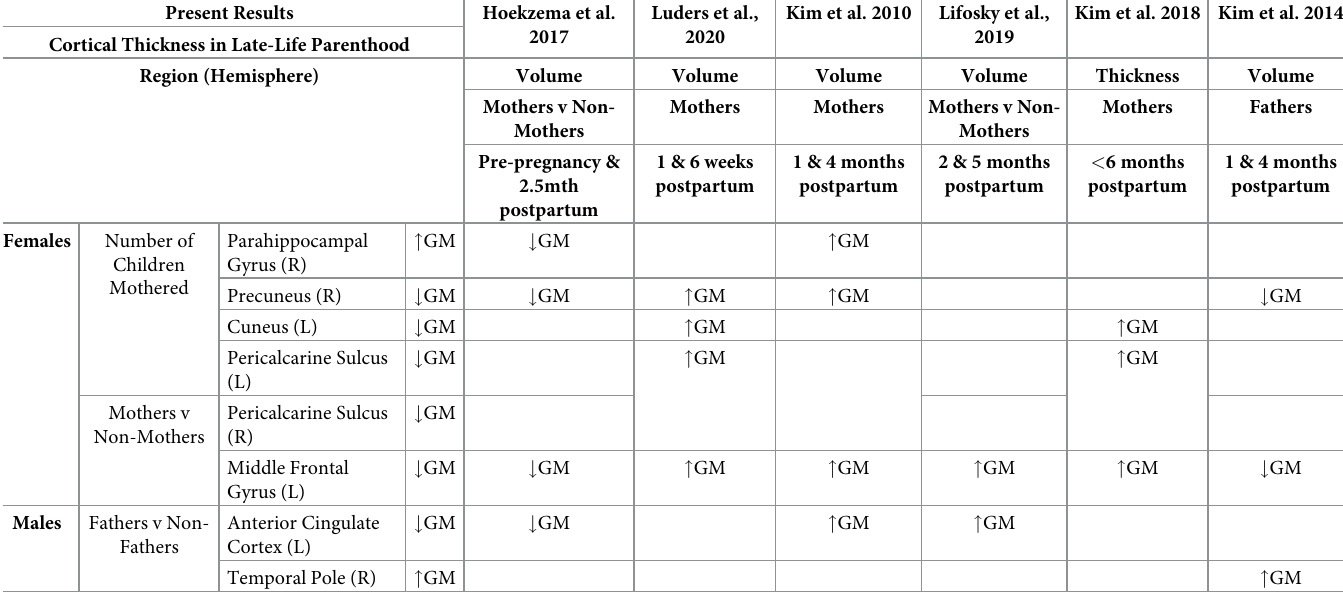
Table 4. Present results in the context of current literature: Grey matter changes observed across early parenthood (pregnancy and the postpartum period). GM = grey matter, " = increased, " = decreased, R = right, L = left. Present